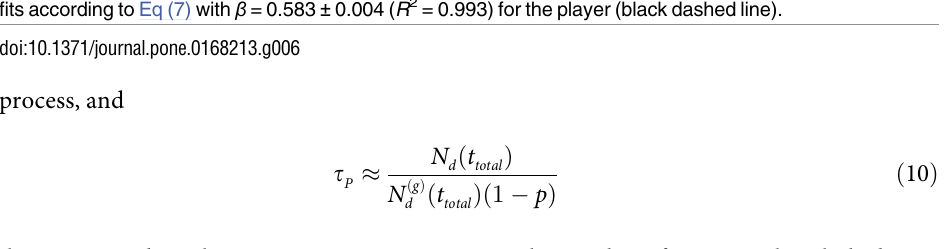
Fig 6. Cumulated inter-event time distribution for a single player (black triangles). Also, corresponding fits accordingto Eq (7) with β = 0.583 ± 0.004 ( R 2 = 0.993) for the player (black